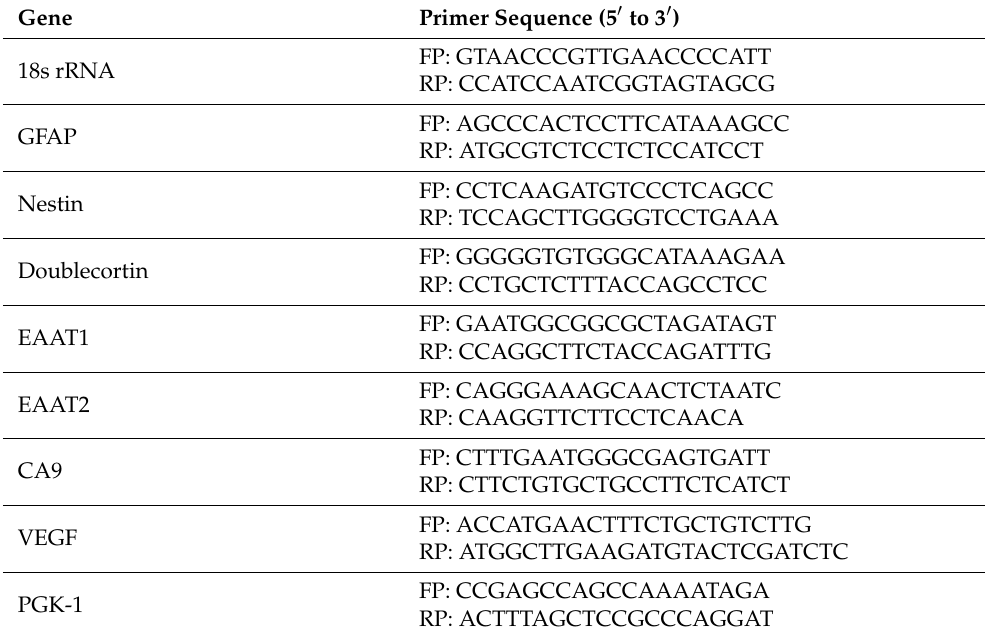
Table 1. Sequences of primers used for gene expression analysis (FP = Forward primer; RP = Reverse